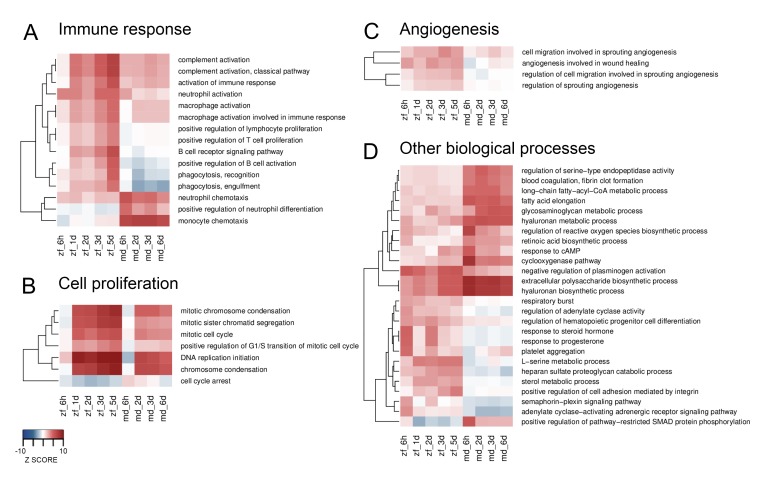
Heatmaps of differentially enriched GO terms from SLEA.GO terms from SLEA analysis of cryoinjured vs. untouched hearts related to immune response (A), cell proliferation (B), angiogenesis (C) and other biological processes (D), were selected and respective Z-scores visualized. Color scales were matched for all four heatmaps, ranking from –10 for underrepresentation to +10 for overrepresentation.